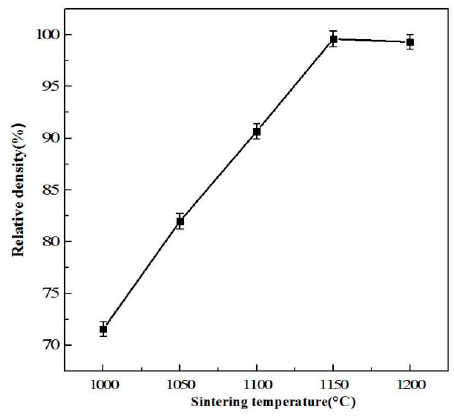
Figure 3. Relative density as a function of sintering temperature of W-6Ni-4Mn alloys.